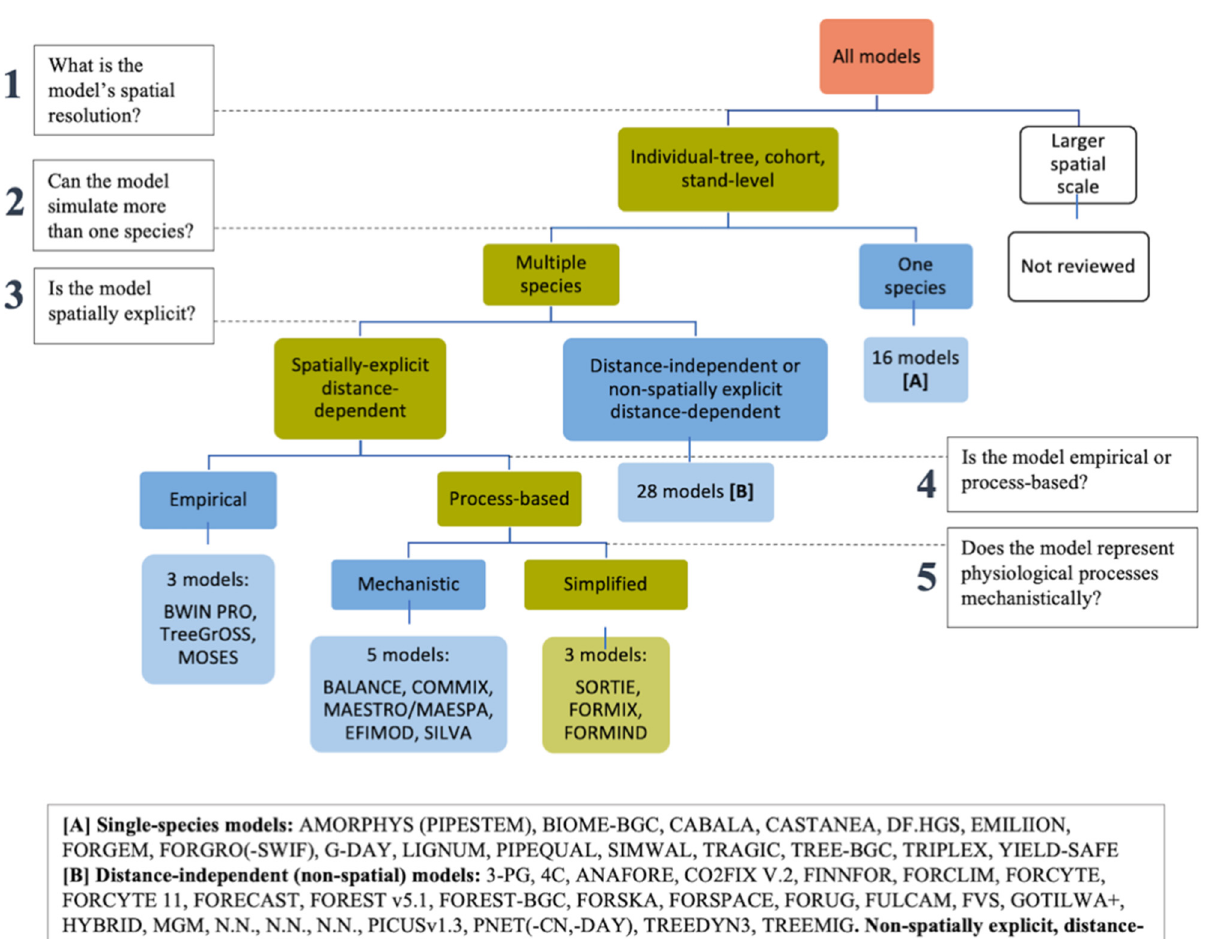
Figure 4. Tiered series of evaluation criteria used to assess the suitability of 54 forest dynamics models for informing small forest management concerns. Characteristics that are more relevant and appropriate for small forests are in green. Characteristics with weaker relevance, or narrow applicability to specific management concerns, are in blue. Characteristics that will not help inform small forest management are in white. Models that best met small forest evaluation criteria include SORTIE, FORMIX, and FORMIND.